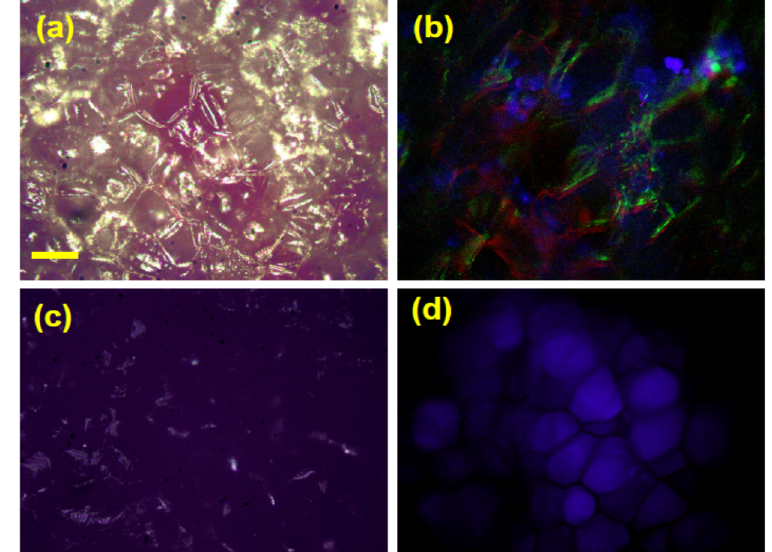
Figure 9. Fluorescence camera intensity images with white light illumination of a free hand slice of raw ( a , b ) and microwaved ( c , d ) Purple Majesty ; ( a , c ) taken using a beam splitter, ( b ) R,B,G composite picture; ( d ) using blue filter cube. The bar (given in (a)) represents ca . 200  m. Adapted from